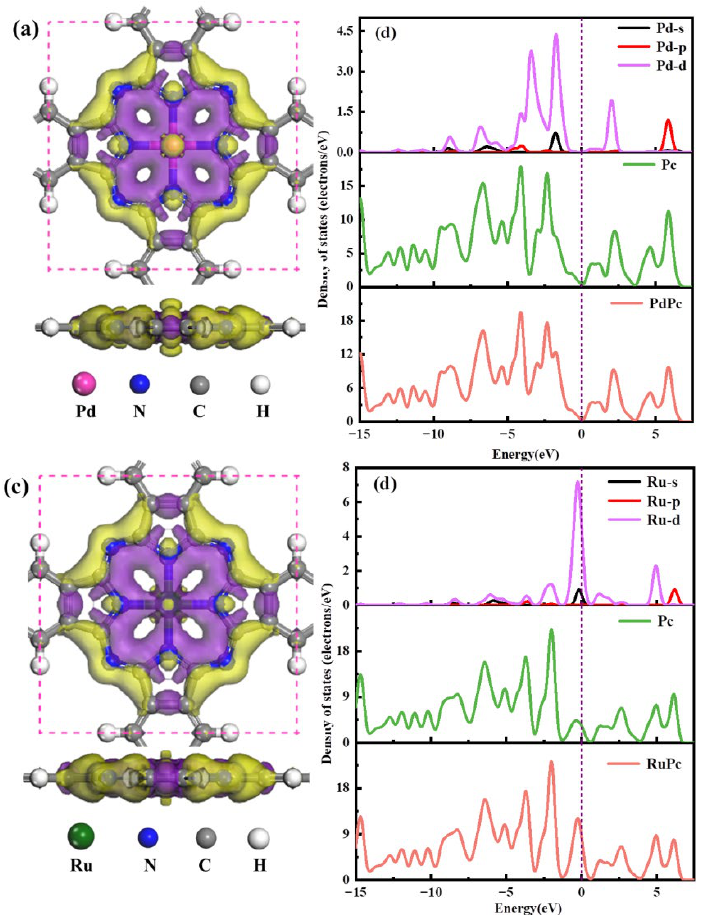
Figure 3. Charge-density difference (CDD) and density of states (DOSs) of the ( a , b ) PdPc and ( c , d ) RuPc monolayers. The yellow (purple) region represents electron accumulation (depletion), and the isosurface value of CDD is ± 0.02 e/Å 3 . The Fermi level is set to zero energy and indicated by the vertical purple dashed line.